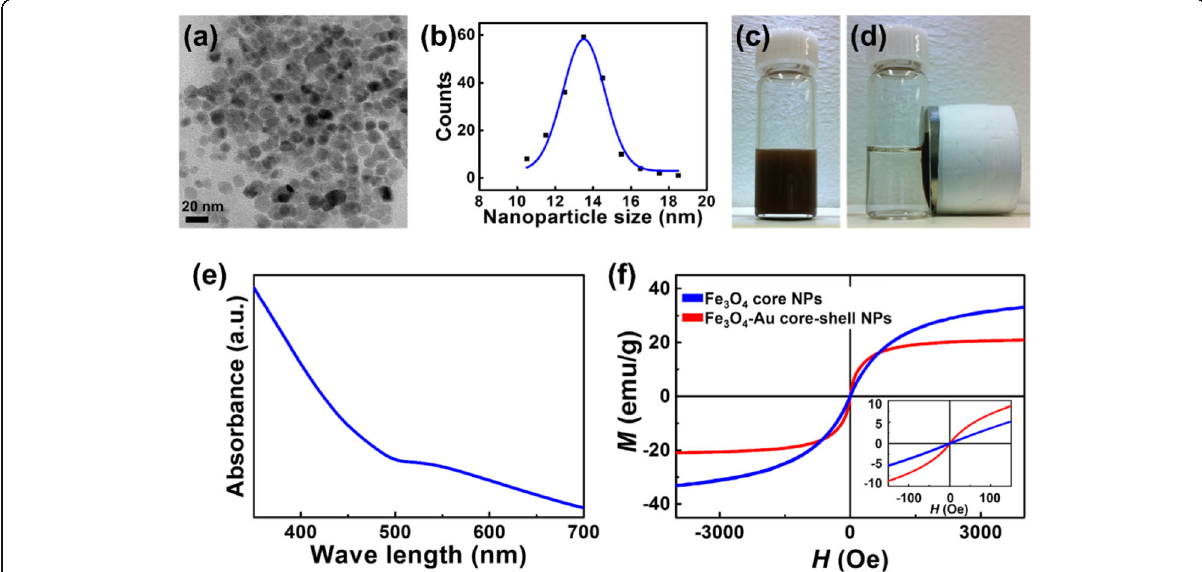
Fig. 1 Characterization of the synthesized Fe 3 O 4 -Au core-shell NPs. a , b TEM observations of the synthesized Fe 3 O 4 -Au core-shell NPs. c , d NPs in aqueous solution, before and after applying an external magnetic field. e UV absorbance peak of synthesized core-shell NPs appears at ~ 530